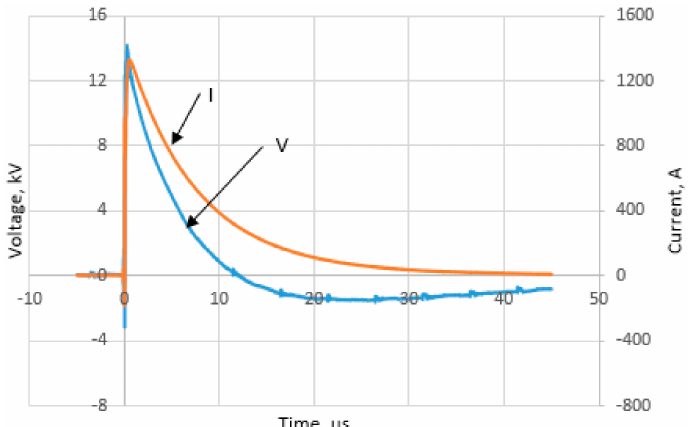
Figure 9. Voltage and current traces of positive polarity for sample A at a charging voltage of 120 kV.